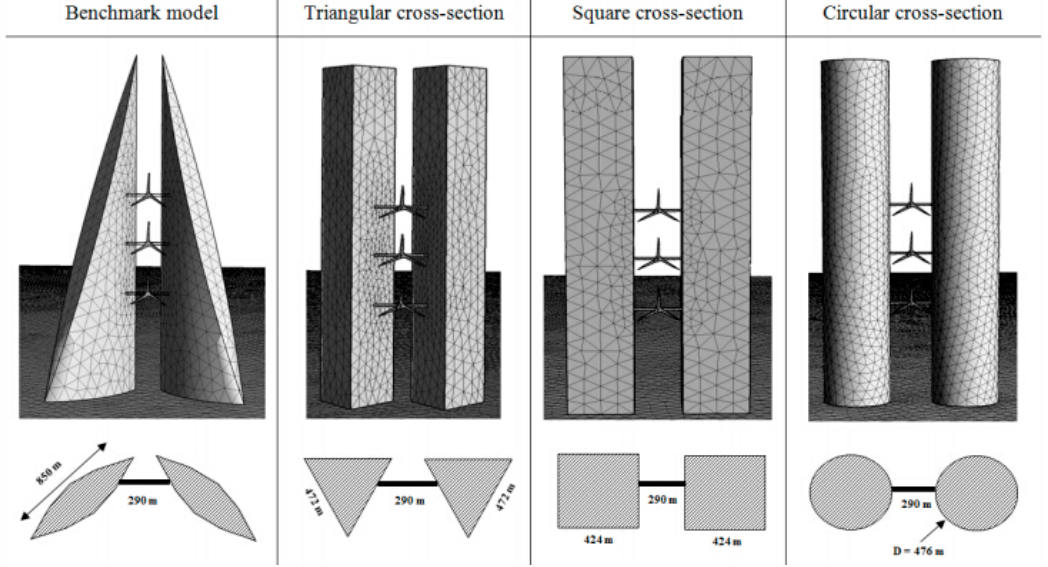
Figure 14. Integration of wind turbines into buildings with different shapes.